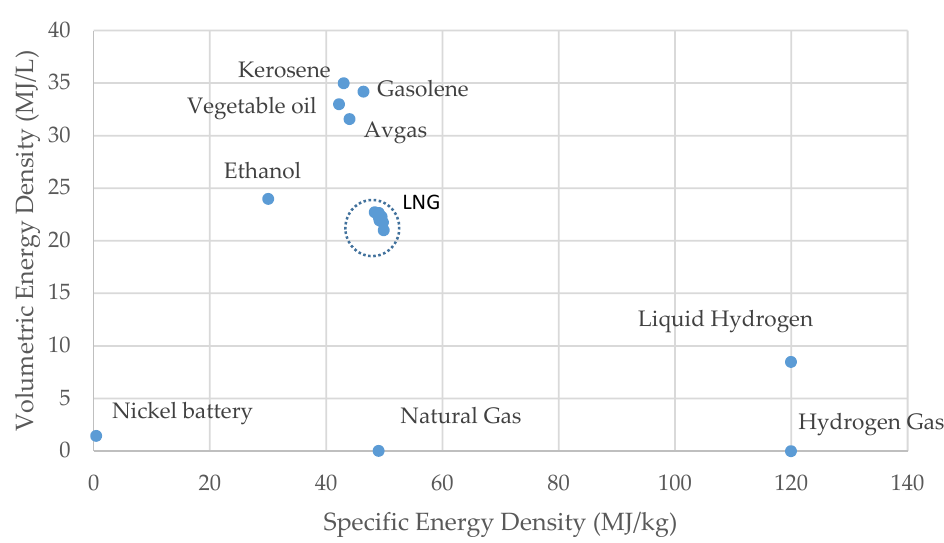
Figure 1. Fuel energy density comparison Figure 2. Energy Density Comparison Chart [16]